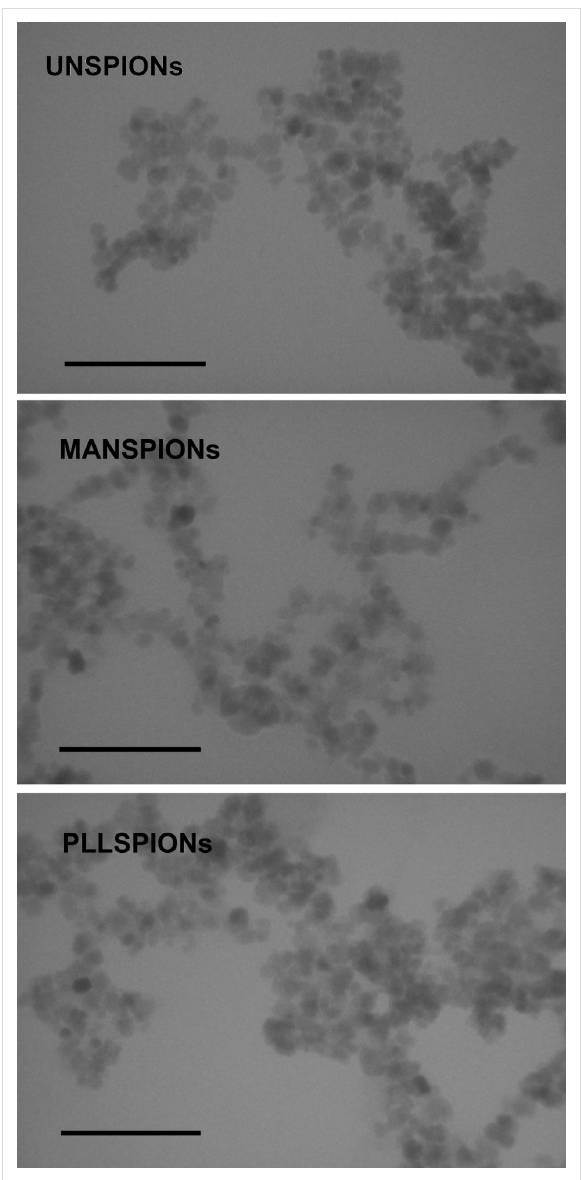
Figure 3: Transmission electron micrographs (TEM) of differently coated superparamagnetic iron oxide nanoparticles: uncoated (UNSPION) and coated with D-mannose (MANSPION) and poly(L- lysine) (PLLSPION). Scale bars are 100 nm.